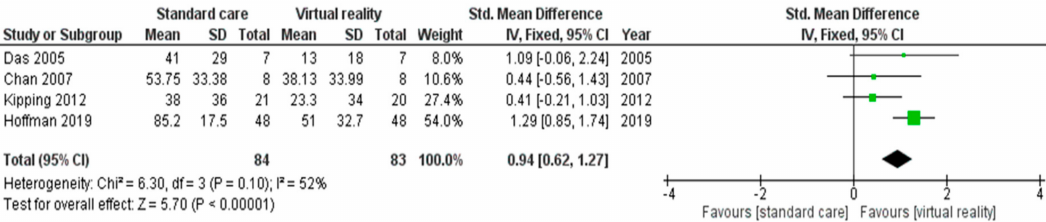
Figure 2. Forest plot: Fixed e ff ects meta-analysis for the e ff ect of virtual reality (VR) on self-reported pain during dressing changes compared to standard care (SC) [SD = standard deviation; IV = weighted mean di ff erence; I 2 = I-square heterogeneity statistic; CI = confidence interval; df = degrees of freedom; Z = Z